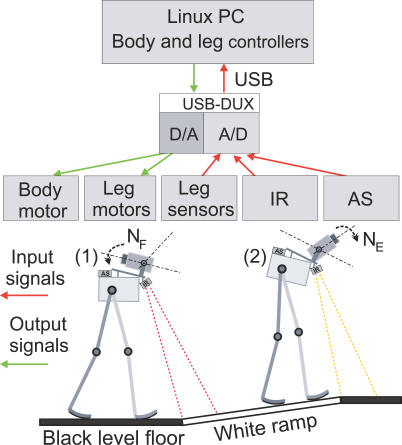
Schematic Setup of the RunBot SystemLeg sensors consist of joint angle sensors and ground contact switch sensors, leg motors are the motors of the left and right hip and knee joints, and the body motor indicates the motor of the UBC. IR and AS stand for infrared and accelerometer sensors, respectively. The detection range of the IR sensor for slope sensing is shown in the lower picture. Note that the red ray of the IR sensor indicates that the sensor gives a high output signal while the yellow ray means a low signal. Hence, the sensor responds more strongly to the white ramp.